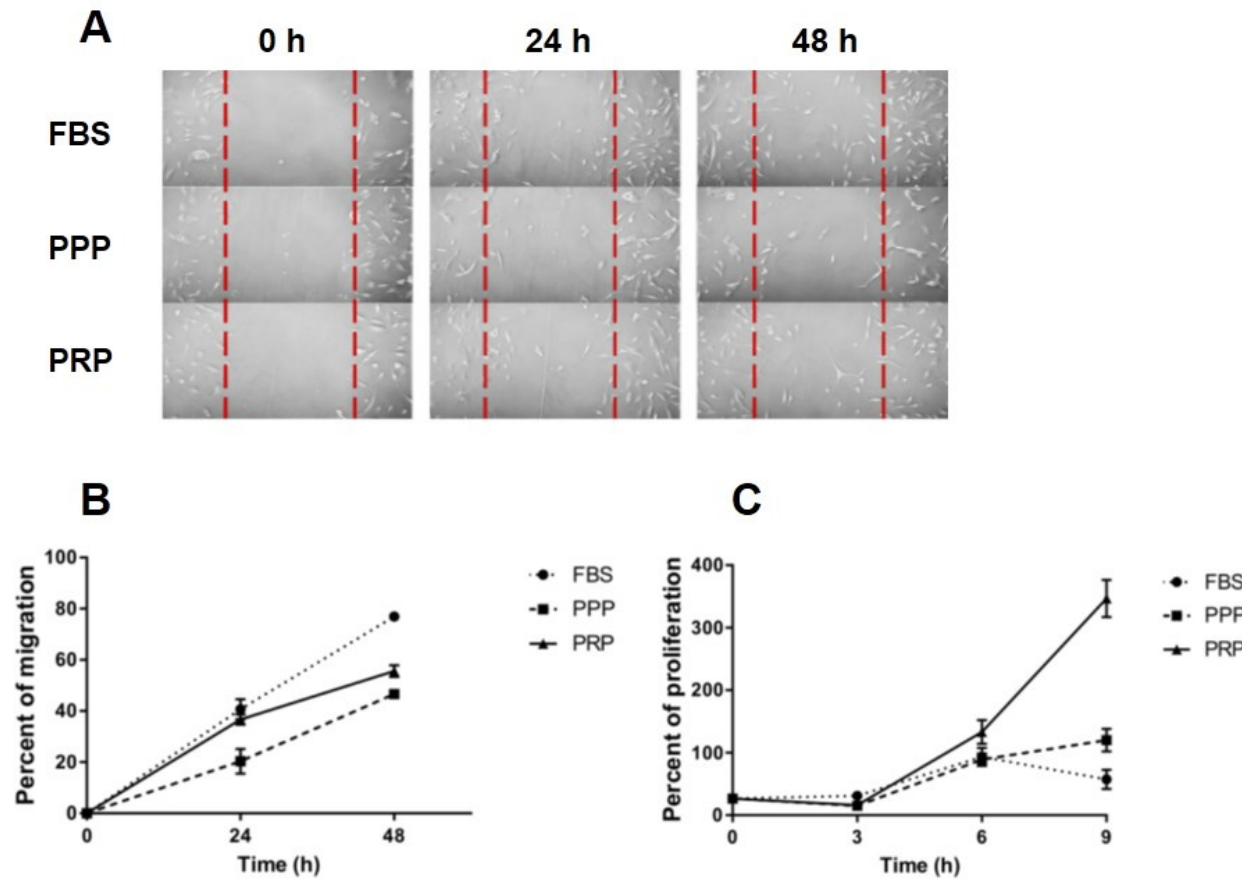
Figure 2. Effects of PRP, PPP, and FBS on migration and proliferation of OA chondrocytes: ( A ) scratch assay images captured at 0, 24, and 48 h using an inverted light microscope to observe migration of knee OA chondrocytes; ( B ) migration of knee OA chondrocytes cultured with PRP, PPP, and FBS at 0, 24, and 48 h; ( C ) proliferation of knee OA chondrocytes cultured with PRP, PPP and FBS at 0, 3, 6, and 9 h. Abbreviations: FBS, fetal bovine serum; OA, osteoarthritis; PRP, platelet-rich plasma; PPP, platelet-poor plasma.